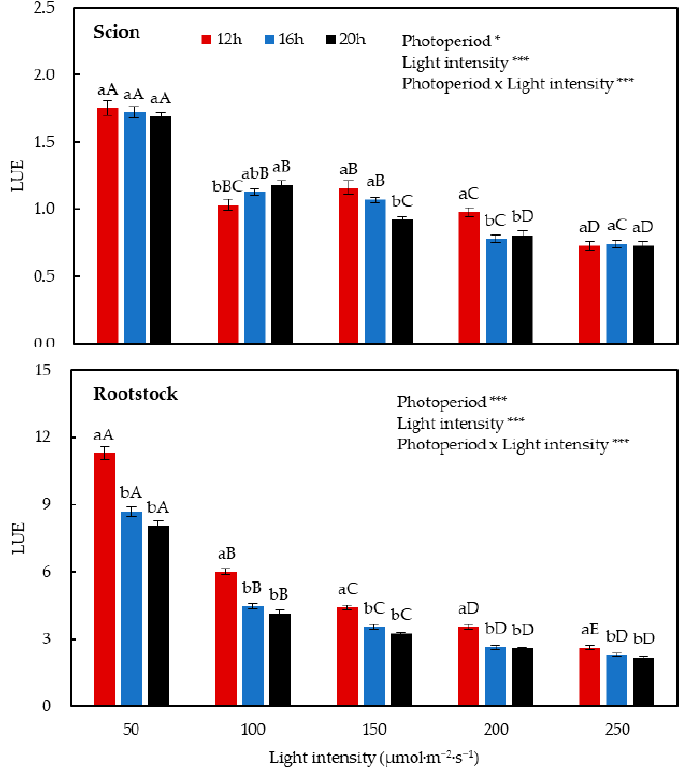
Figure 11. Light use efficiency (LUE) of cucumber scions and rootstocks as affected by the different photoperiod and light intensity treatments in a PFAL. The error bar indicates the standard error of the mean for 3 replicates with 7 samples. * and *** indicate significant differences at p < 0.05 and 0.001, respectively. Values with different letters differ significantly at the 95% level according to Tukey’s HSD test. Lowercase letters compares photoperiod treatments for each light intensity treatment. Uppercase letters compare light intensity treatments for each photoperiod treatment.